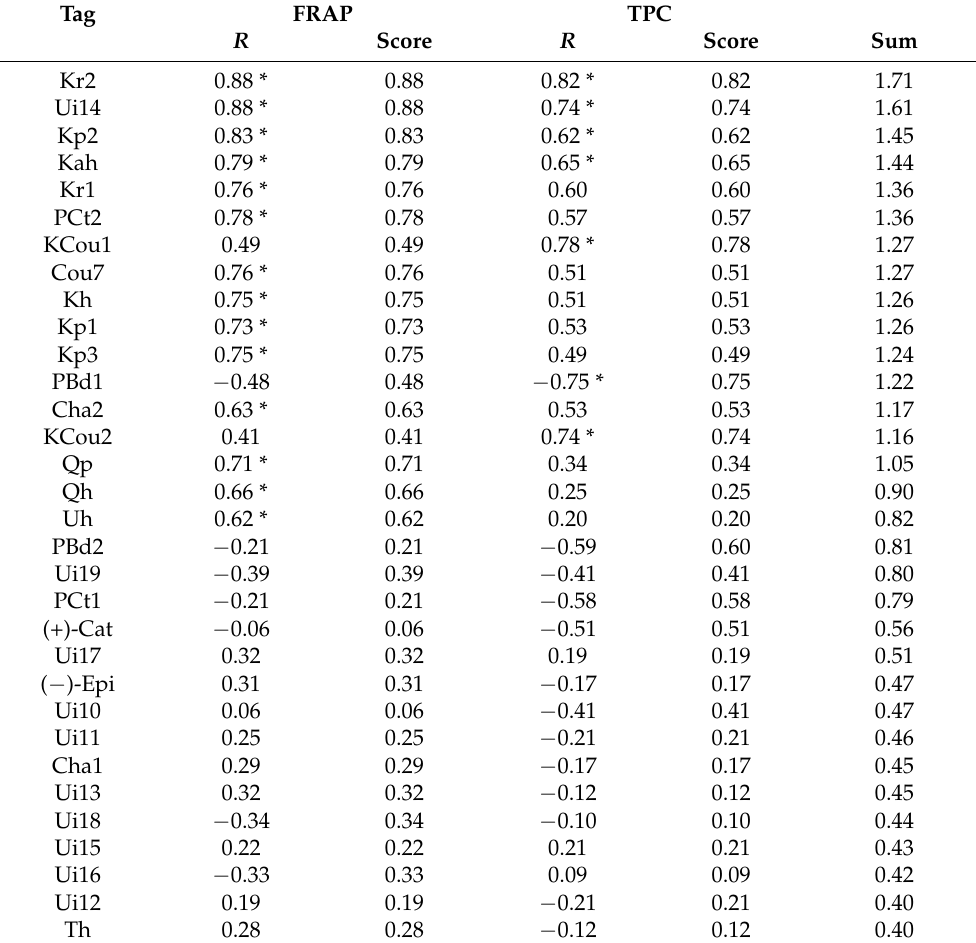
Table 5. Correlation analysis of the polyphenol peak areas and antioxidant properties of eastern hemlock cone extracts. Significant correlations (for p < 0.05, n = 11, | R | ≥ 0.60) were marked with an asterisk. FRAP: Ferric Reducing Antioxidant Power; TPC: Total Polyphenol Content. For the interpretation of the tags please refer to Table 1.